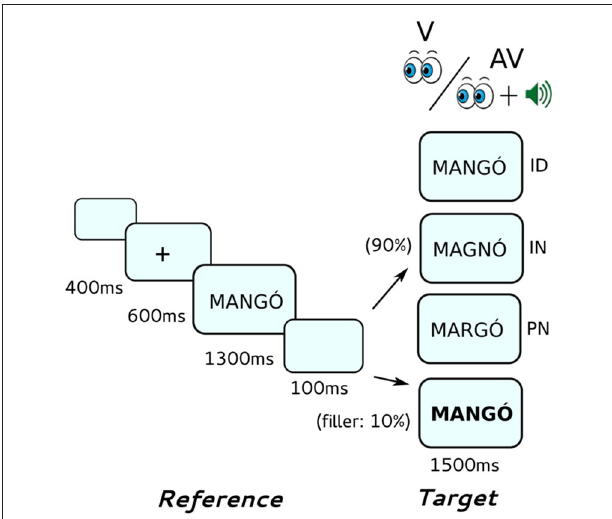
FIGURE 1 | Outline of the same-different implicit reading task. Reference stimuli were always presented visually, target stimuli were presented either visually only (V) or audiovisually (AV). Target stimuli could be either identical (ID), different in the identity of one letter (IN) or different in the position of letters (PP) compared to the reference stimuli.